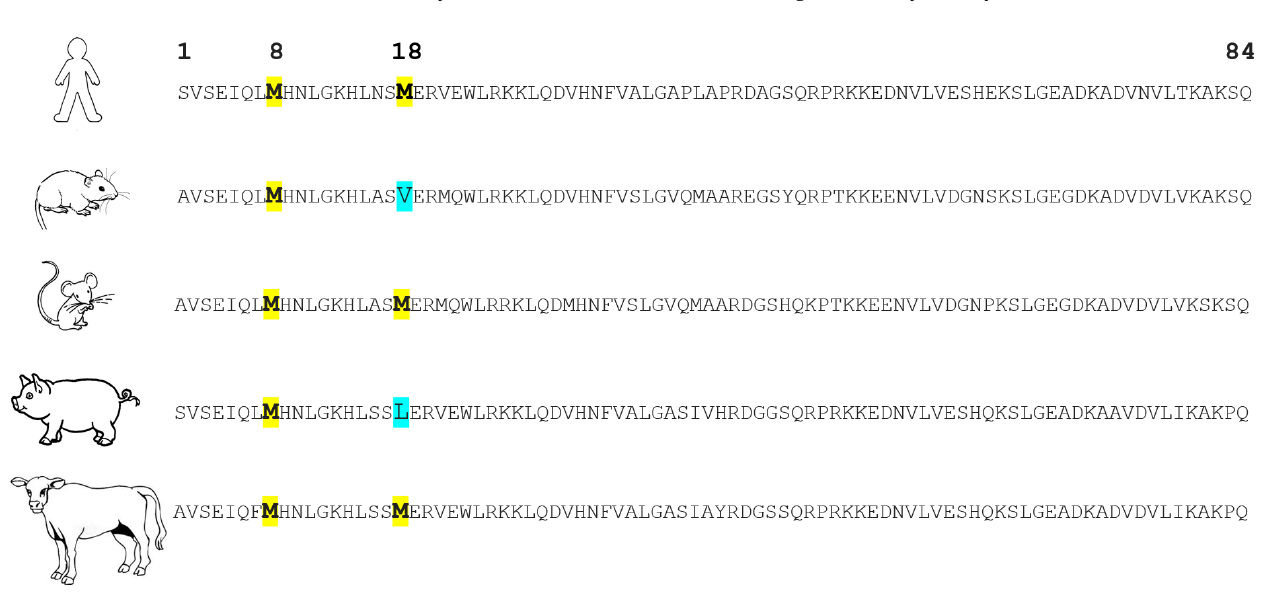
Figure 2. Amino acid sequences of parathyroid hormone (1-84) across different species. Amino acid sequences are adapted from https://www.uniprot.org/, accessed on 15 August 2022. The letters represent the IUPAC codes for amino acids. Amino acids at positions 8 and 18 (methionines in humans) are